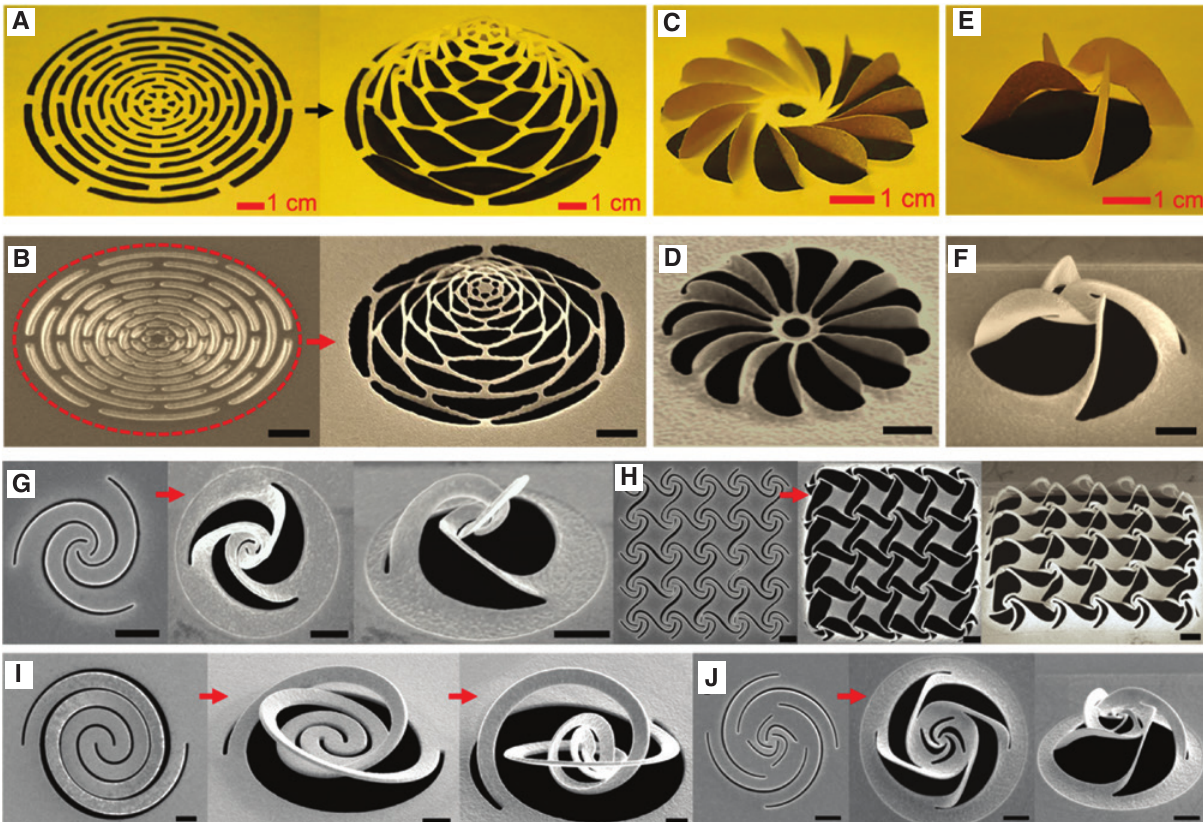
Figure 6: Macro-kirigami by hand and close-loop nano-kirigami by global FIB irradiation [39]. (A, C, E) Camera images of the macroscopic paper kirigami of (A) an expandable dome, (C) a 12-blade propeller, and (E) a four-arm pinwheel. (B, D, F) Corresponding microscopic structures reproduced by close-loop nano-kirigami with global FIB irradiation. (G–J) Top-view and side- view SEM images of typical structures before and after global FIB irradiation: (G) a twisted triple Fibonacci spiral; (H) window-decoration- type nanobarriers; (I) a deformable spiral; (J) a combined spiral structure. Scale bars: 1 μ